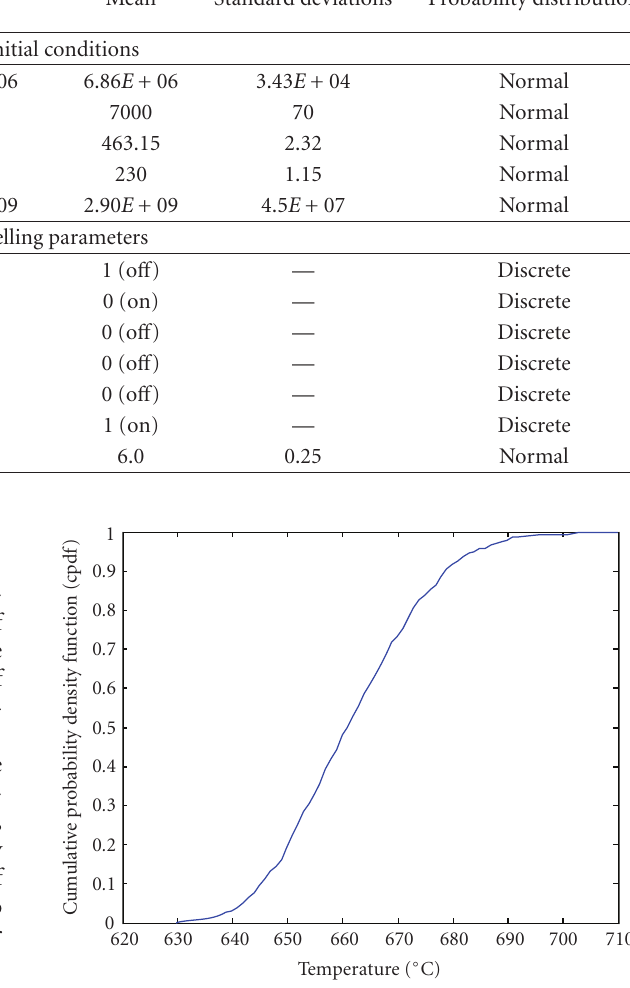
Table 1: Parameters which are regarded relevant with respect to the behaviour of the fuel cladding temperature [21]. Parameter